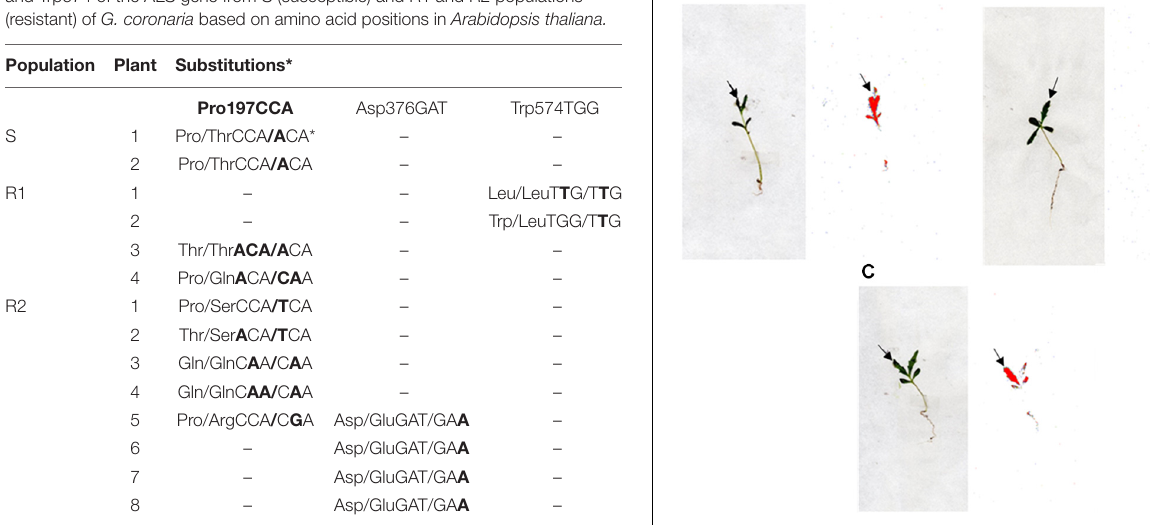
TABLE 5 | Absorption (expressed as % of recovered radioactivity) and translocation to different plant organs (expressed as % of absorbed radioactivity) of 14 C-tribenuron in S, R1, and R2 populations of G. coronaria at 12, 24, 48, and 72 HAT. Population HAT Absorption (%)